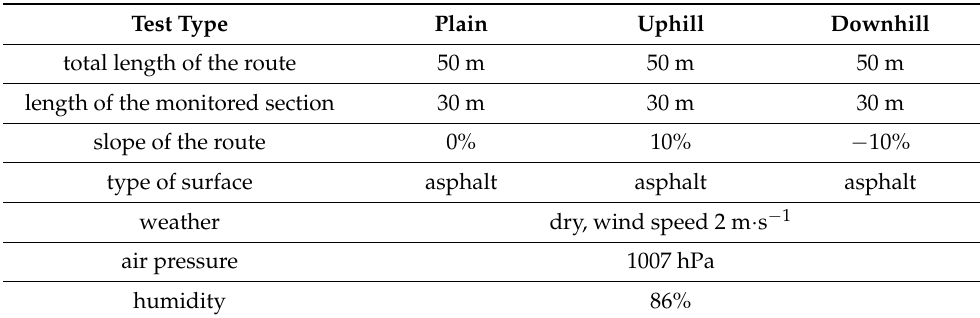
Table 3. Technical data of the measuring route